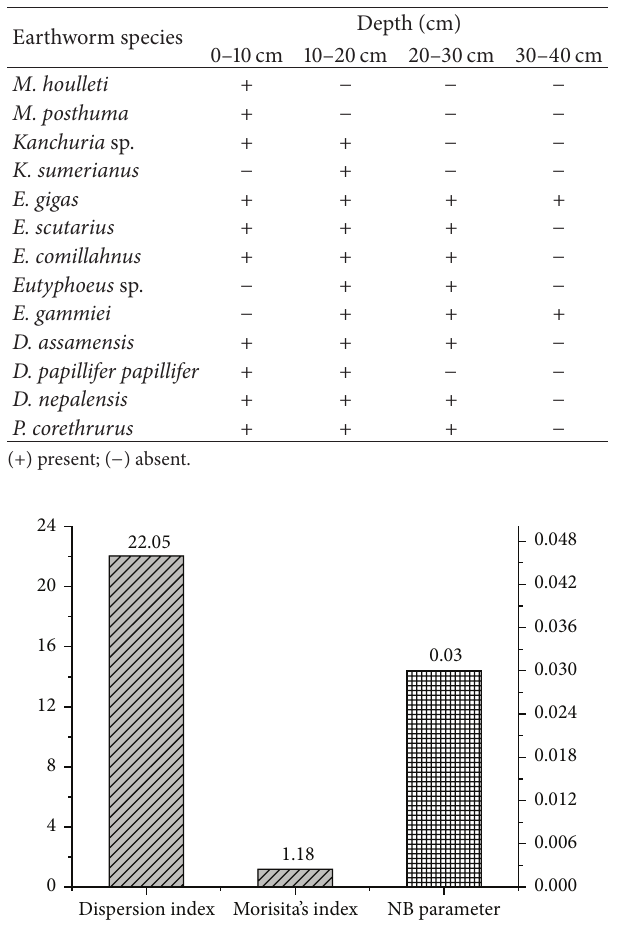
Figure 3: Showing the values of three different dispersion indices indicating the higher degree of clumped horizontal distribution of the earthworm community in pineapple plantation.